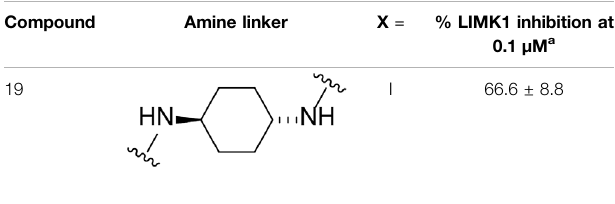
TABLE 1 | Synthesis of initial investigation of linker chain and halide substitutions. TABLE 1 | ( Continued ) Synthesis of initial investigation of linker chain and halide